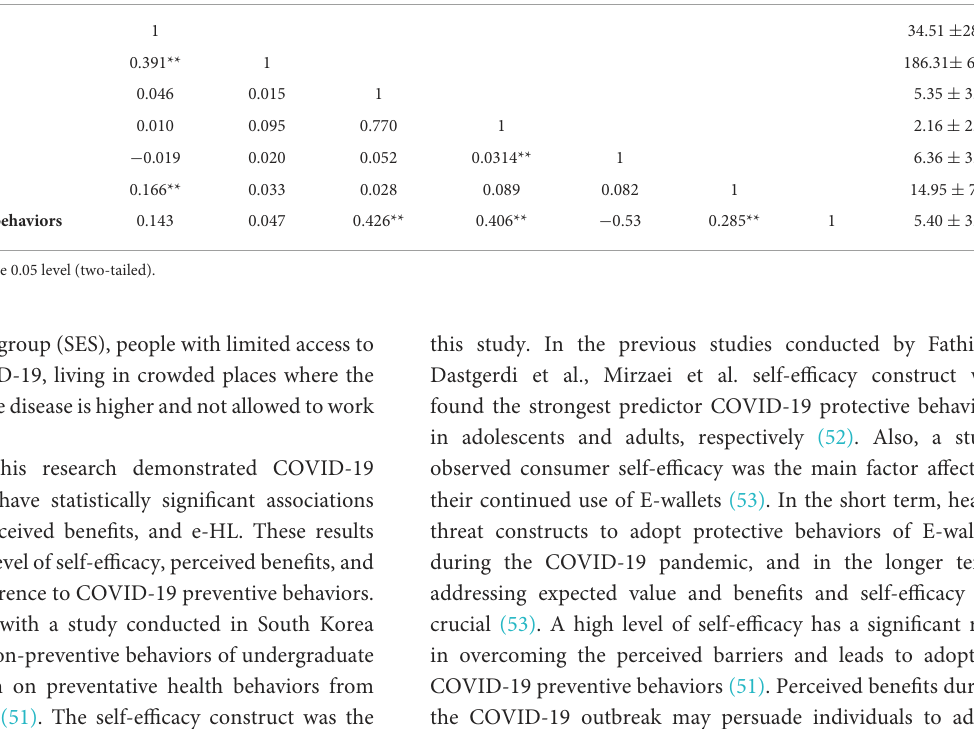
TABLE 2 Bivariate correlation matrix of the relationship between HBM structures, eHL dimension, and HPBs.